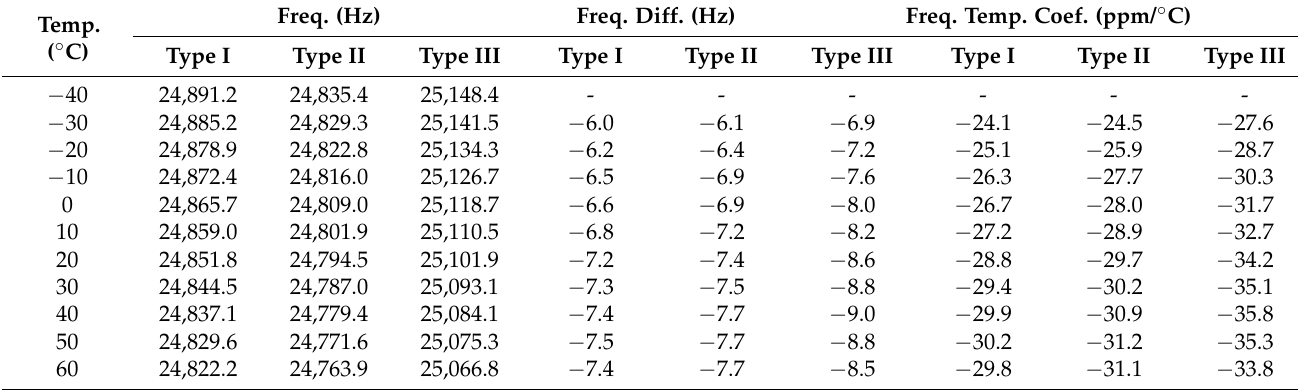
Table 2. The temperature characteristic test results of the resonator with soft adhesive. Temp.